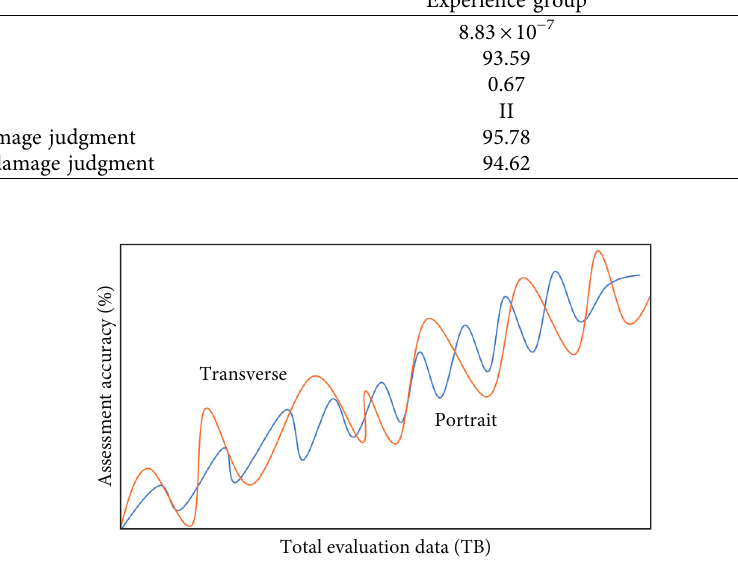
Figure 7: Accuracy of risk assessment of transverse and longitudinal sports injury.